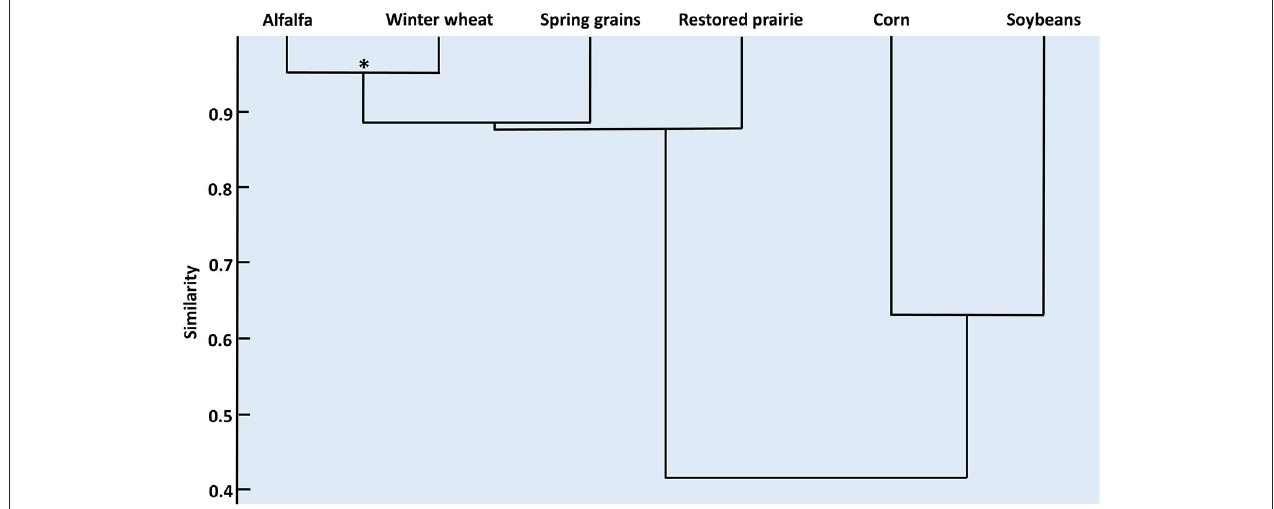
FIGURE 2 | Dendrogram depicting the relationships among coccinellid assemblages in six habitats in east-central South Dakota based on correlations of species rank abundance. * p < 0.001.